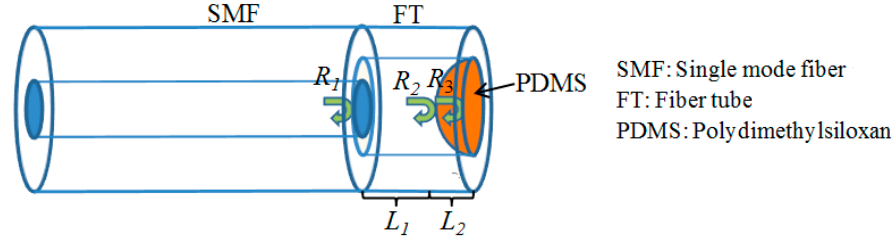
Figure 1. Sketch of the fabricated PDMS thin film immersed Fabry-Perot fiber optic pressure sensor.